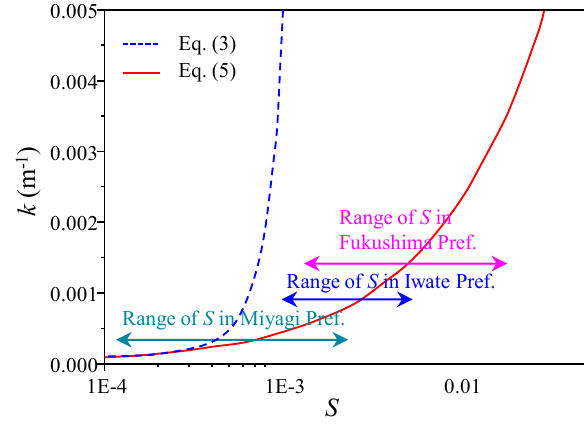
Figure 8. Relationship of damping coefficient and riverbed slope.